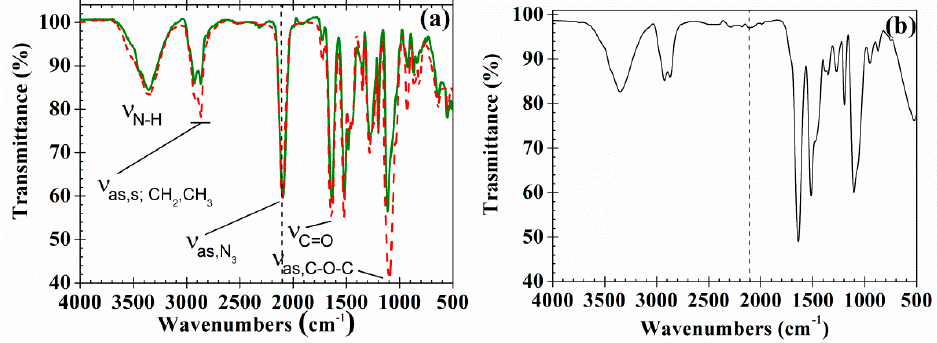
Figure 3. ( a ) Normalized ( ν as,N3 peak) FTIR spectra of PAzMa1 (continuous line) and PAzMa2 (dash dot line) films and ( b ) FTIR spectra of PAzMa1 after thermal treatment (heated in TGA from rt to 250 ◦ C at 1 ◦ C · min − 1 ).